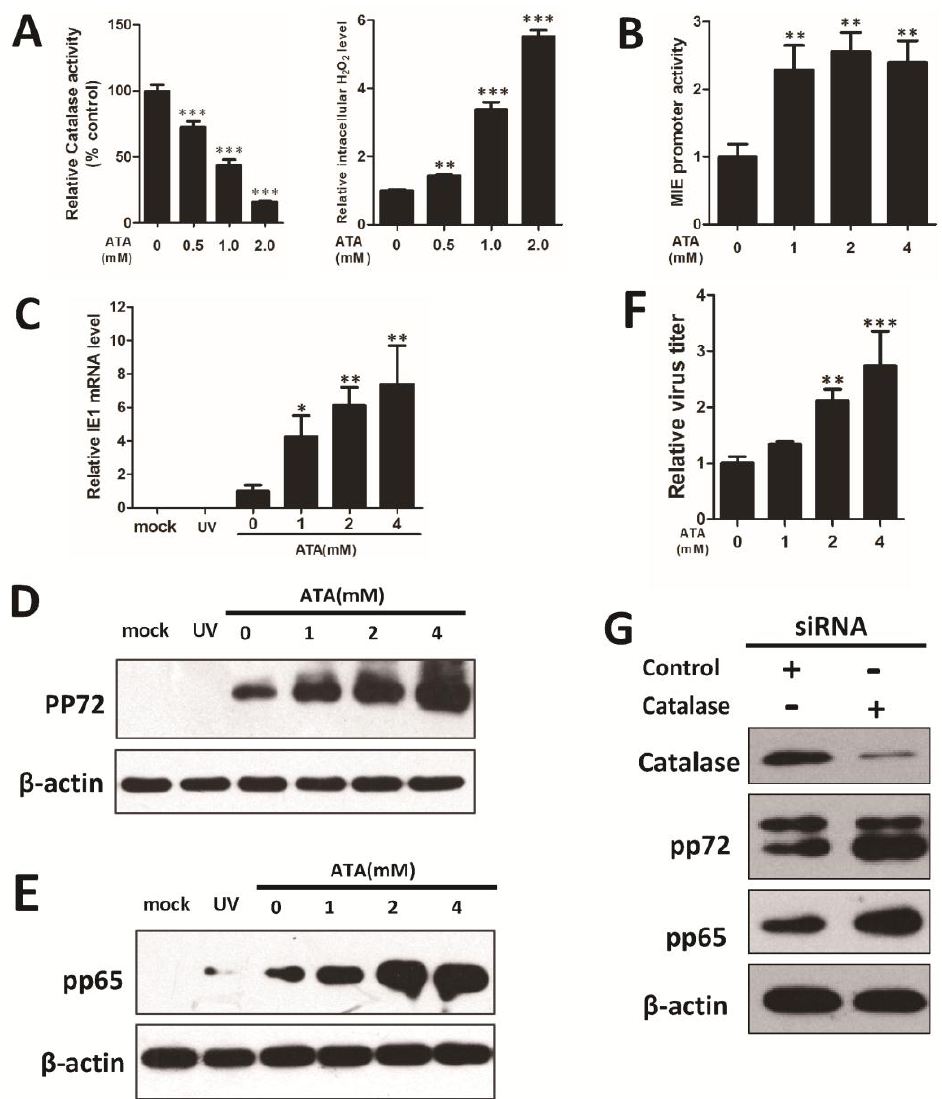
Figure 3. ATA-induced intracellular H 2 O 2 , enhancing viral replication in HFF cells. Treatment of HFF cells with the catalase inhibitor 3-amino-1,2,4-triazole (ATA) (0, 1, 2, 4 mM) for 24 h reduced catalase activity and increased intracellular H 2 O 2 level in a dose-dependent manner ( A ). Cells were cultured with ATA for 24 h. ATA-induced intracellular H 2 O 2 increased MIE promoter activity ( B ) and HCMV IE1 transcription ( C ). Cells were infected with UV-HCMV (UV) or HCMV at an MOI of 0.5. An increase in pp72 ( D ) and pp65 ( E ) protein levels were detected by Western blotting under 0, 1, 2, 4 mM ATA treatments for 72 h, and β-actin was used to calibrate sample loading. ( F ) Relative virus titers were measured using TCID 50 assay within five days. ( G ) Catalase, HCMV lytic protein pp72, pp65 and β-actin levels were determined by Western blotting after treatment with siRNA for five days. * p < 0.05; ** p < 0.01 or *** p < 0.001 for ATA-treated versus untreated cells.